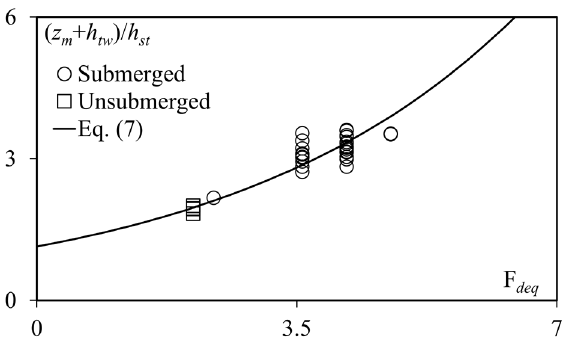
Figure 9. ( z m + h tw )/ h st vs F deq for chevrons in submerged and unsubmerged conditions, along with the plot of Equation (7).